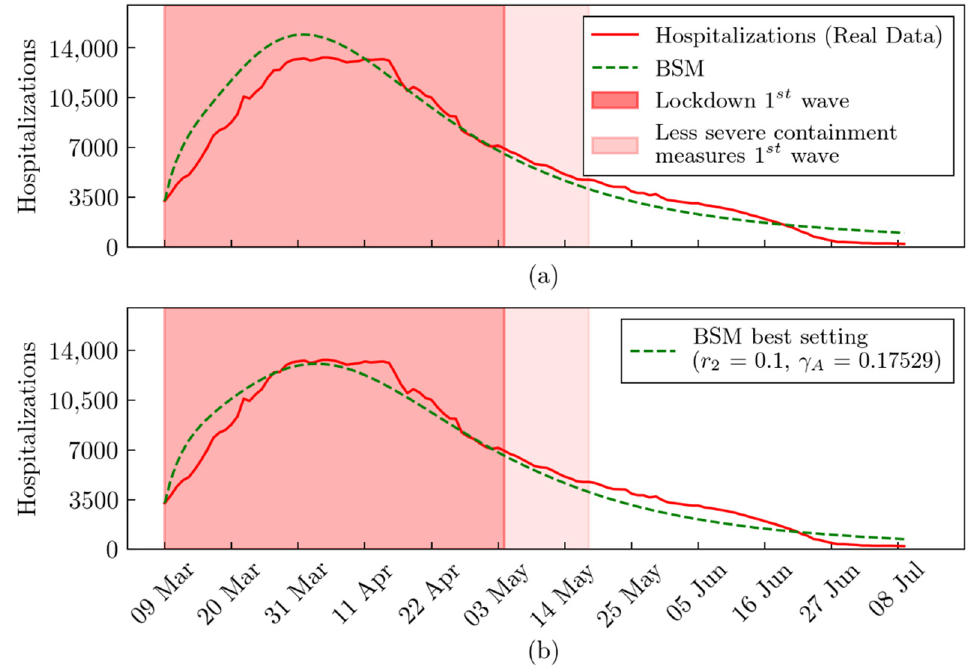
Figure 3. Basic SEIR Model (BSM) hospitalization predictions. BSM hospitalization predictions (dashed green line) compared with real hospitalization data (red line) in the period from 9 March